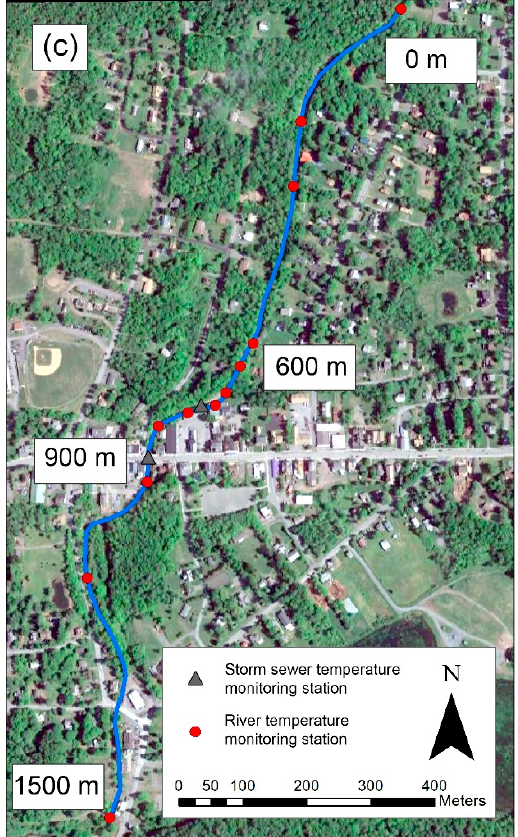
Figure 2. ( a ) New York State with the Sawmill Creek study area denoted by the star. ( b ) Monitoring stations and reach distances along Sawmill Creek.